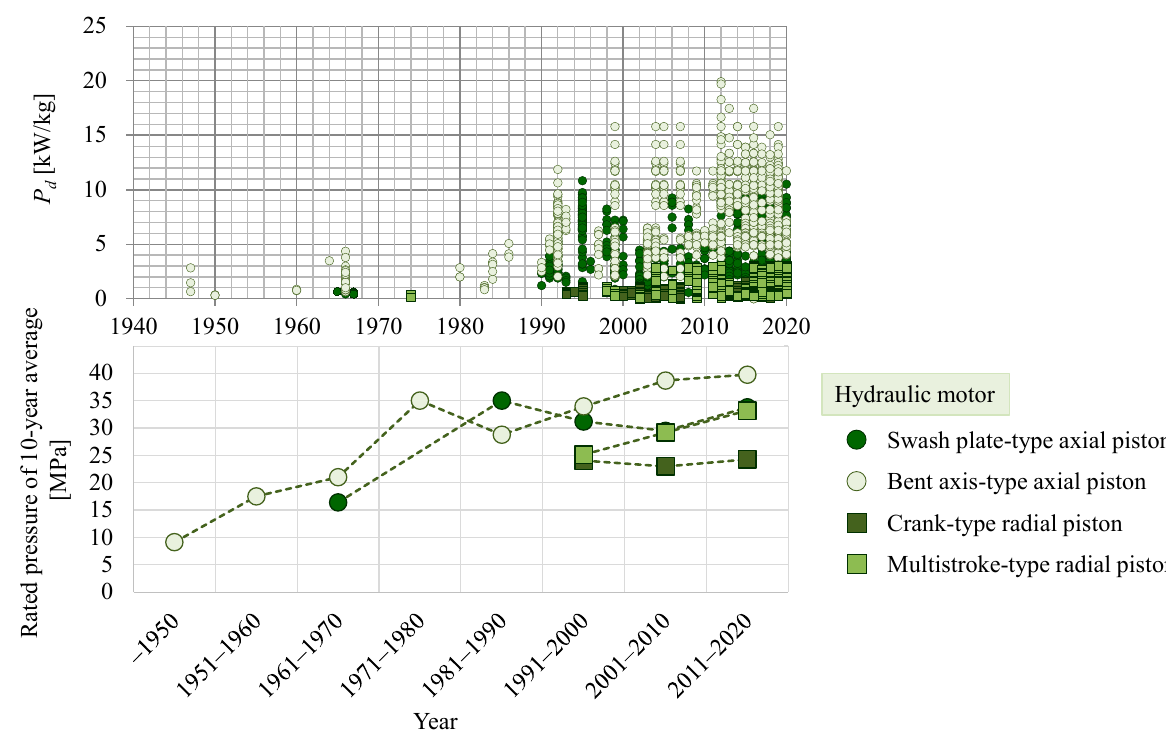
Figure 3. Transition of power density and rated pressure of hydraulic motors.